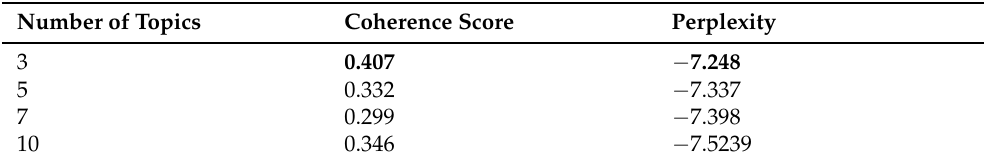
Table 1. Performance of LDA wrt the number of topics. Best performance are reached by a number of topics equal to 3.